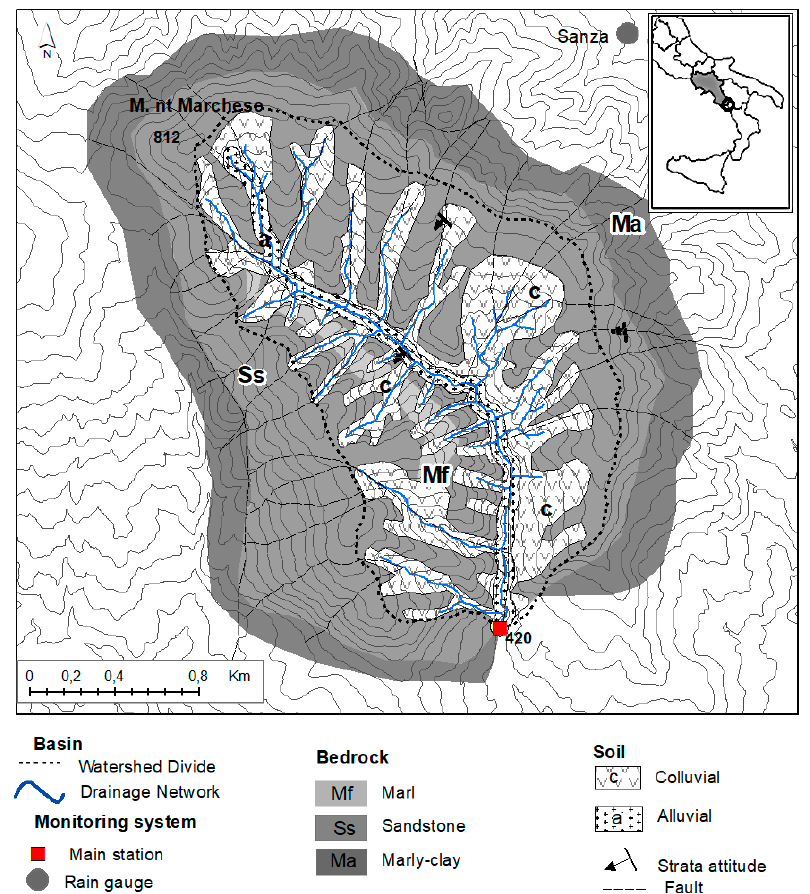
Figure 1. Schematic geological map and monitoring stations of the Ciciriello experimental catchment, Cilento UNESCO Global Geopark.